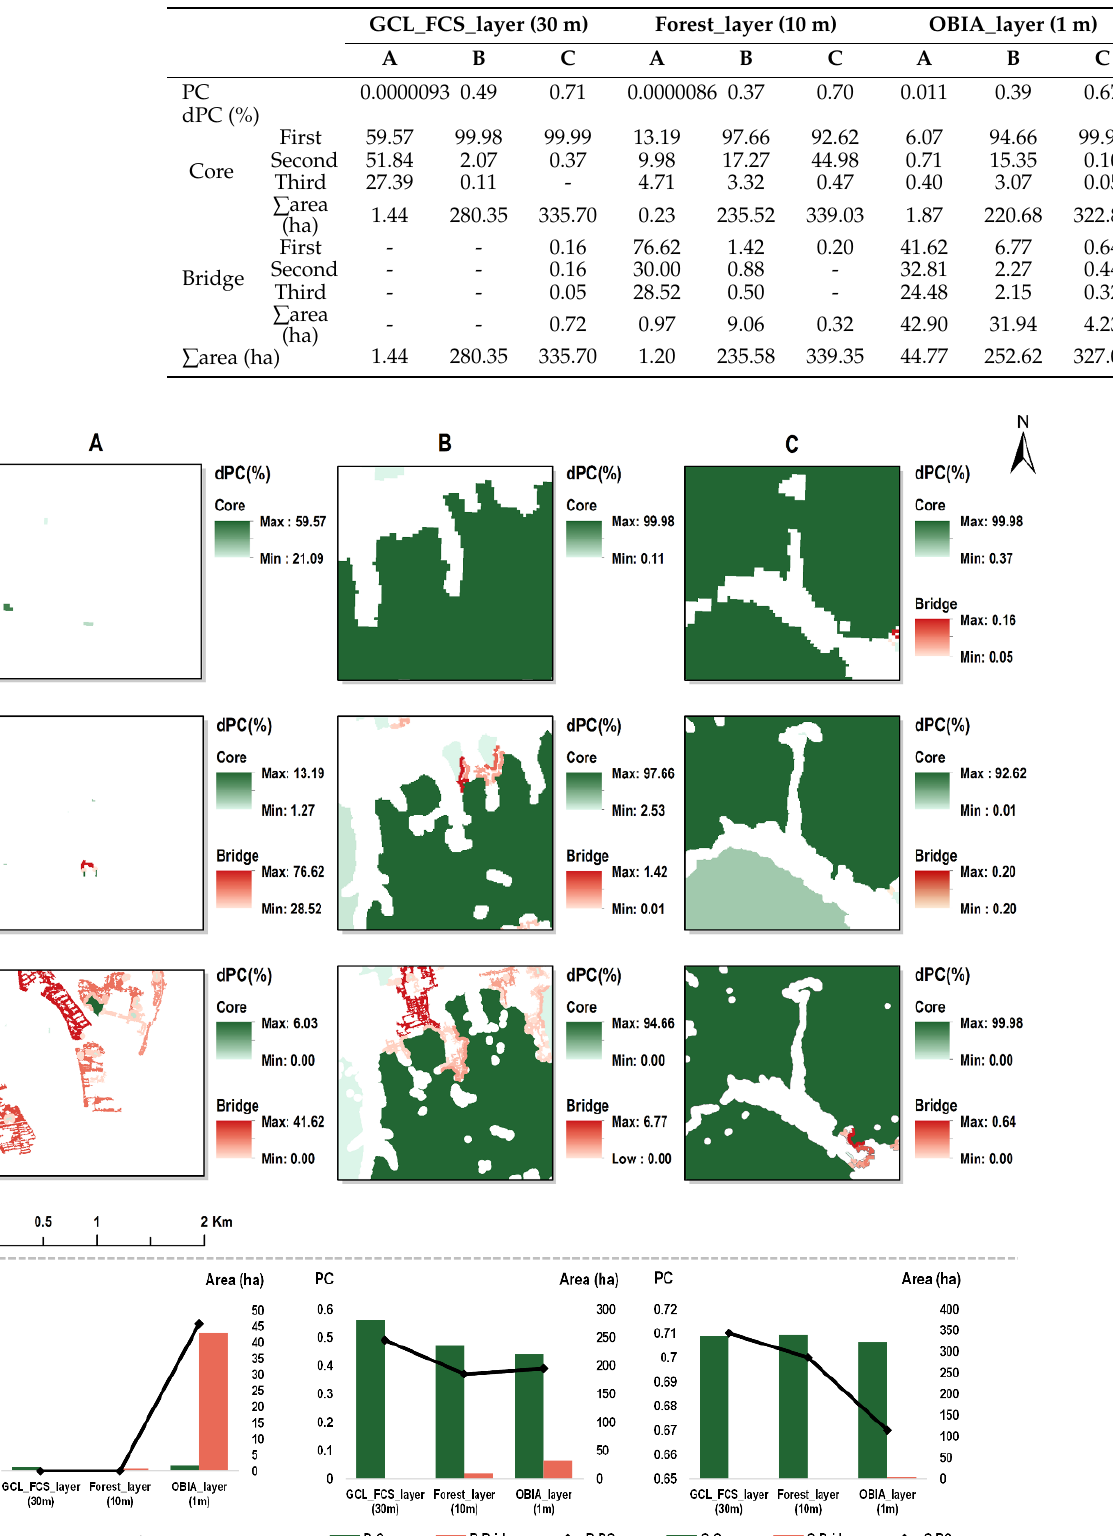
Table 3. PC index results for each UGS cover map: PC value, the top three dPC of Cores and Bridges, and the total area ( ∑ area) of all obtained Cores and Bridges.